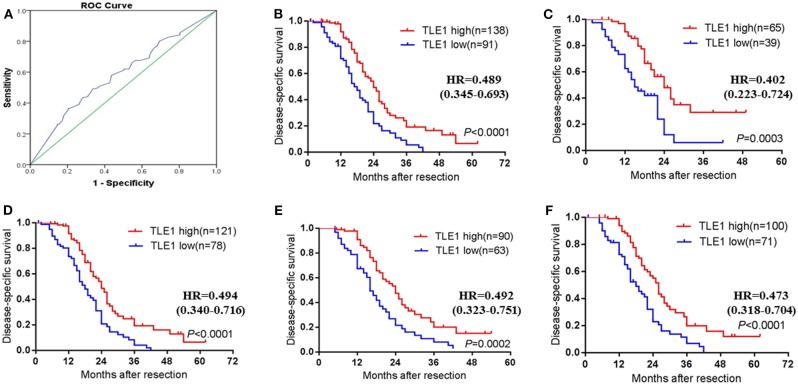
Prognostic impact of TLE1 expression in the whole PDAC patient cohort and selected patient subgroups. (A) ROC curve for tumor H-scores of TLE1 staining for DSS status and the cutoff value. (B) DSS curve for all patients with high or low tumor TLE1 expression (P < 0.0001; log-rank test). (C) Patients aged ≤ 60 years (P = 0.0003; log-rank test). (D) Non-diabetic patients (P < 0.0001; log-rank test). (E) Patients with elevated CA19-9 (P = 0.0002; log-rank test). (F) Patients with tumor size ≤ 4 cm (P < 0.0001; log-rank test). DSS, disease-specific survival; CA19-9, carbohydrate antigen 19-9; TLE1, transducin-like enhancer of split-1; PDAC, pancreatic ductal adenocarcinoma; ROC, receiver operating characteristic (n = 3).